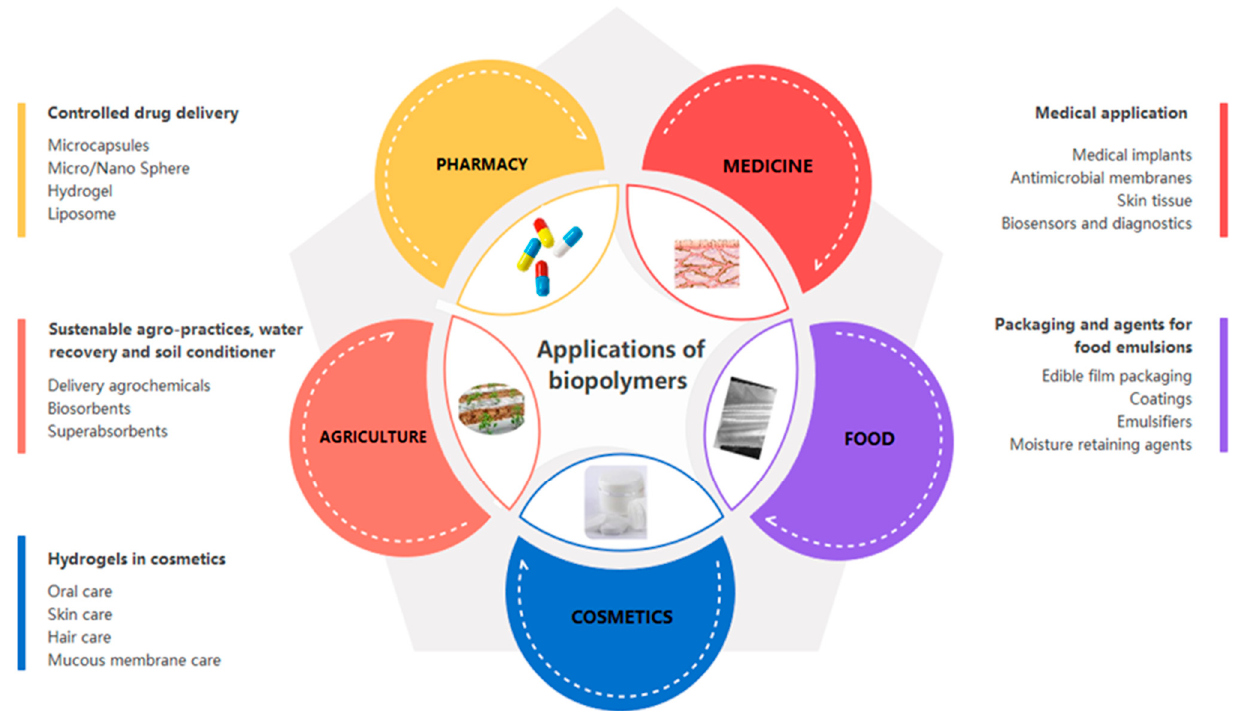
Figure 2. Applications of biopolymers.